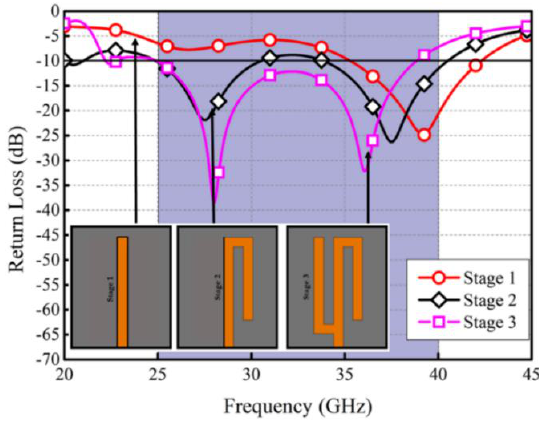
Figure 2. Design Evolution of the proposed Antenna.